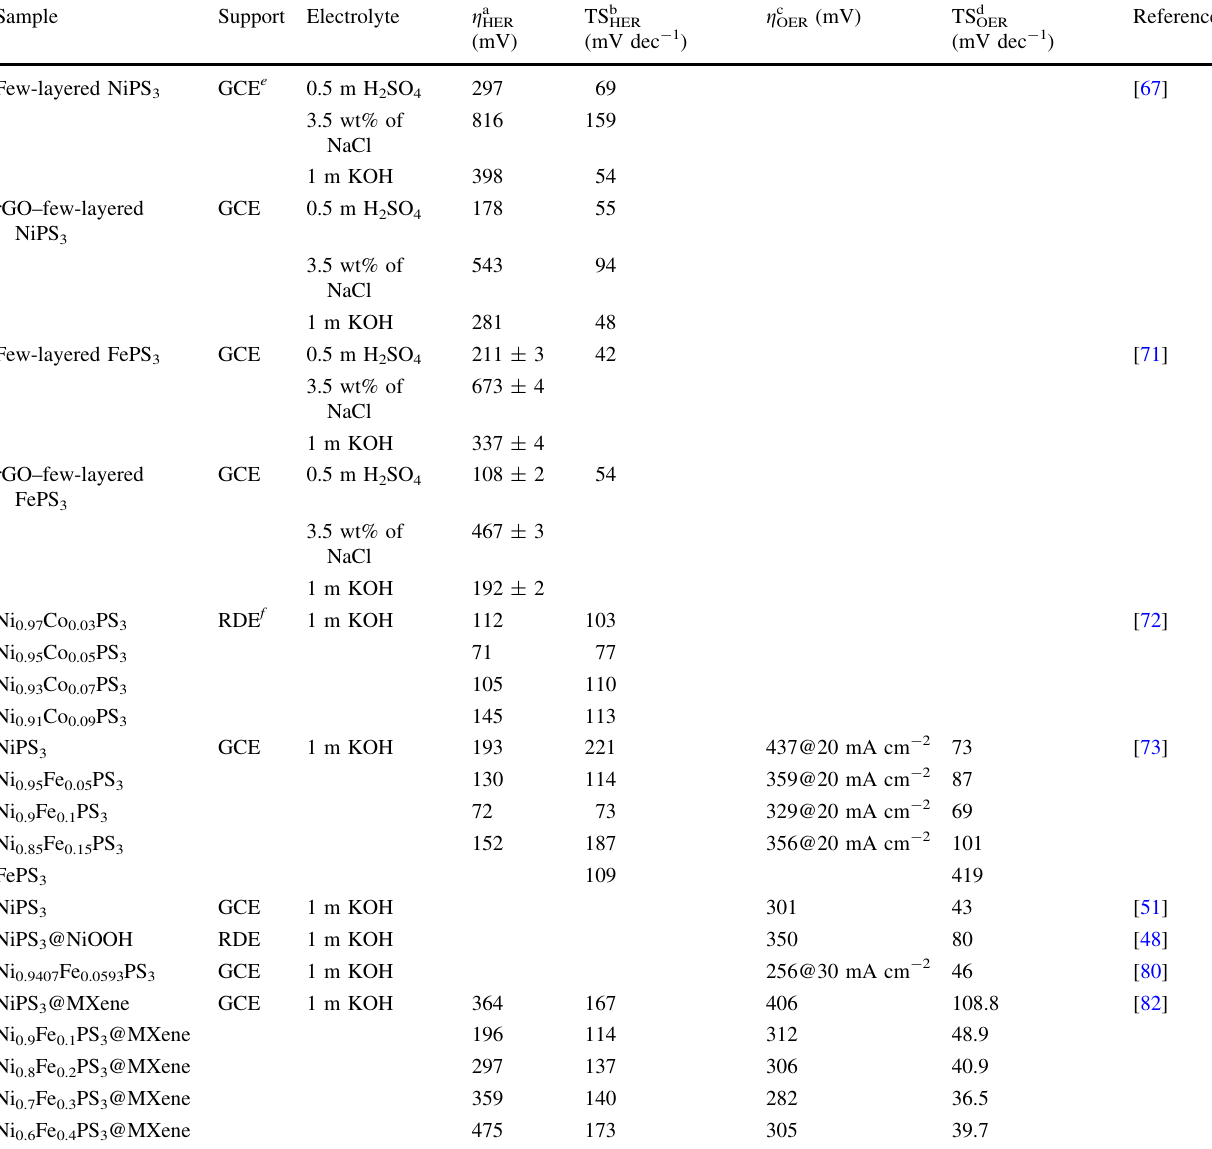
Table 1 Comparison of electrochemical catalytic properties of reported MPQ 3 compounds Sample Support Electrolyte